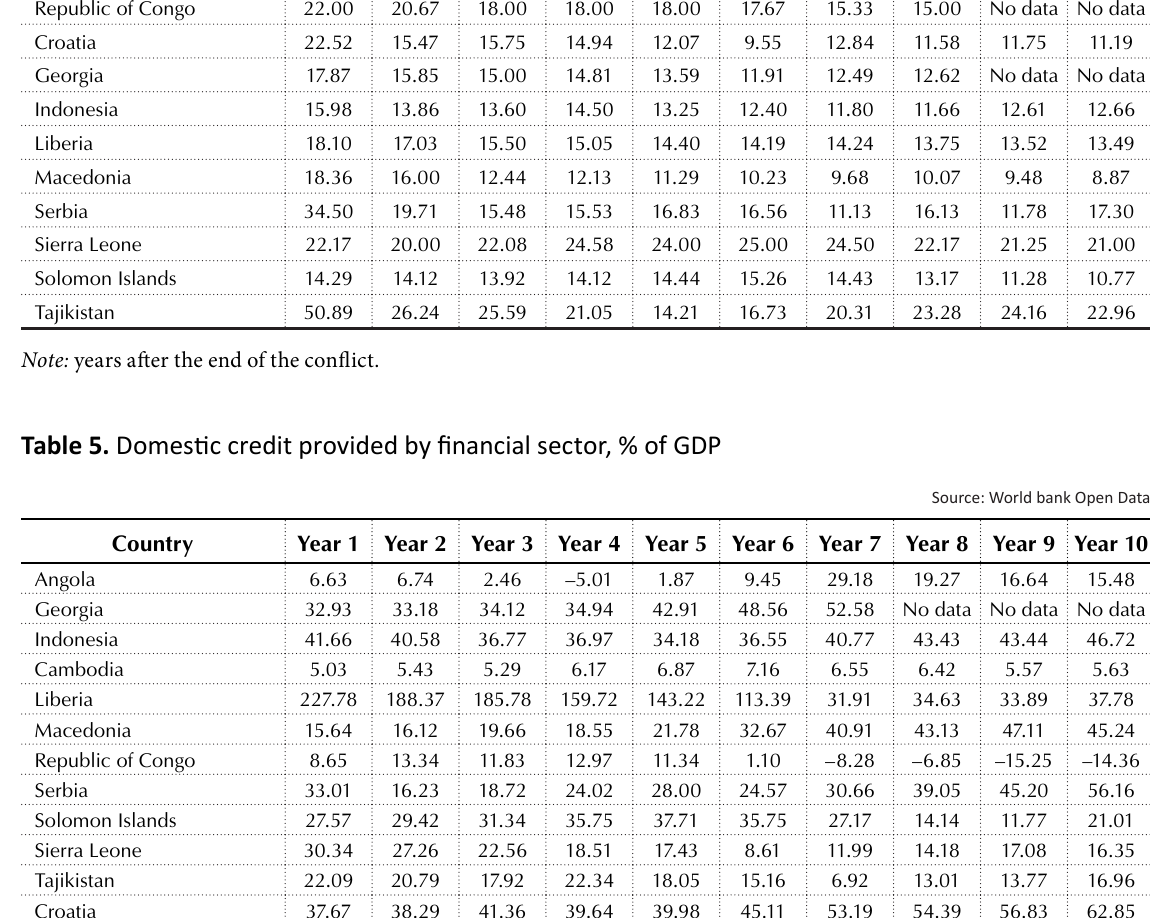
Table 4. Lending interest rate, %